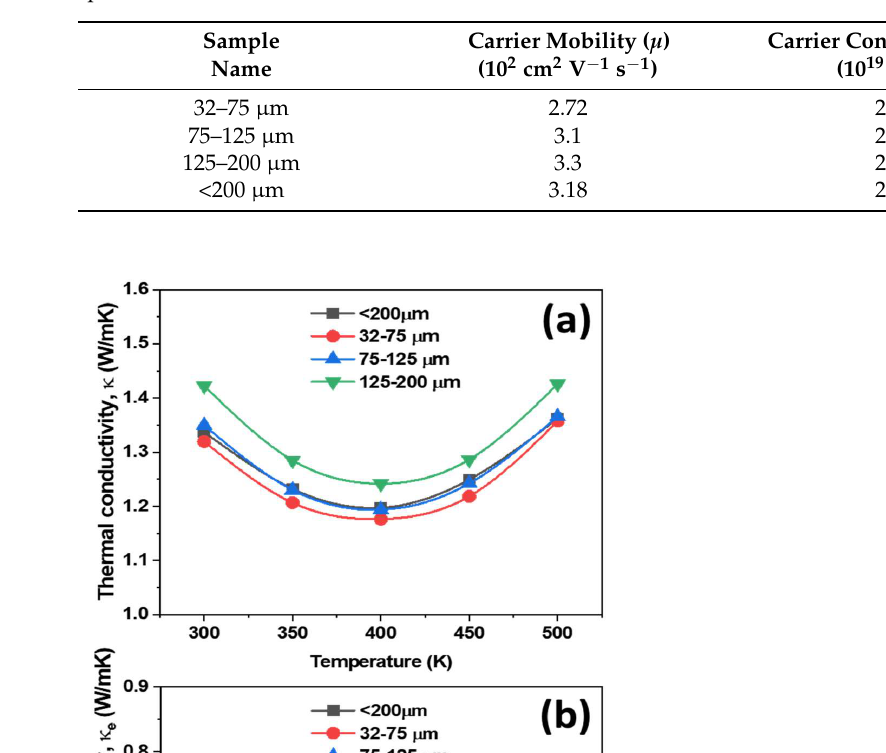
Table 1. Room temperature carrier mobility, and concentration of p-type Cu 0.07 Bi 0.5 Sb 1.5 Te 3 bulk